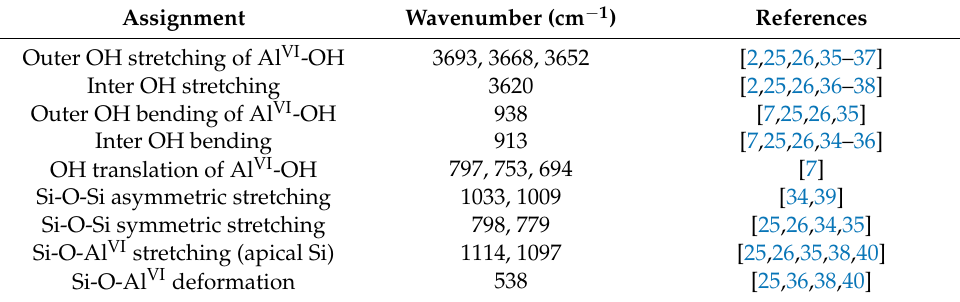
Table 4. Characteristic absorption peaks of FTIR of kaolinite.